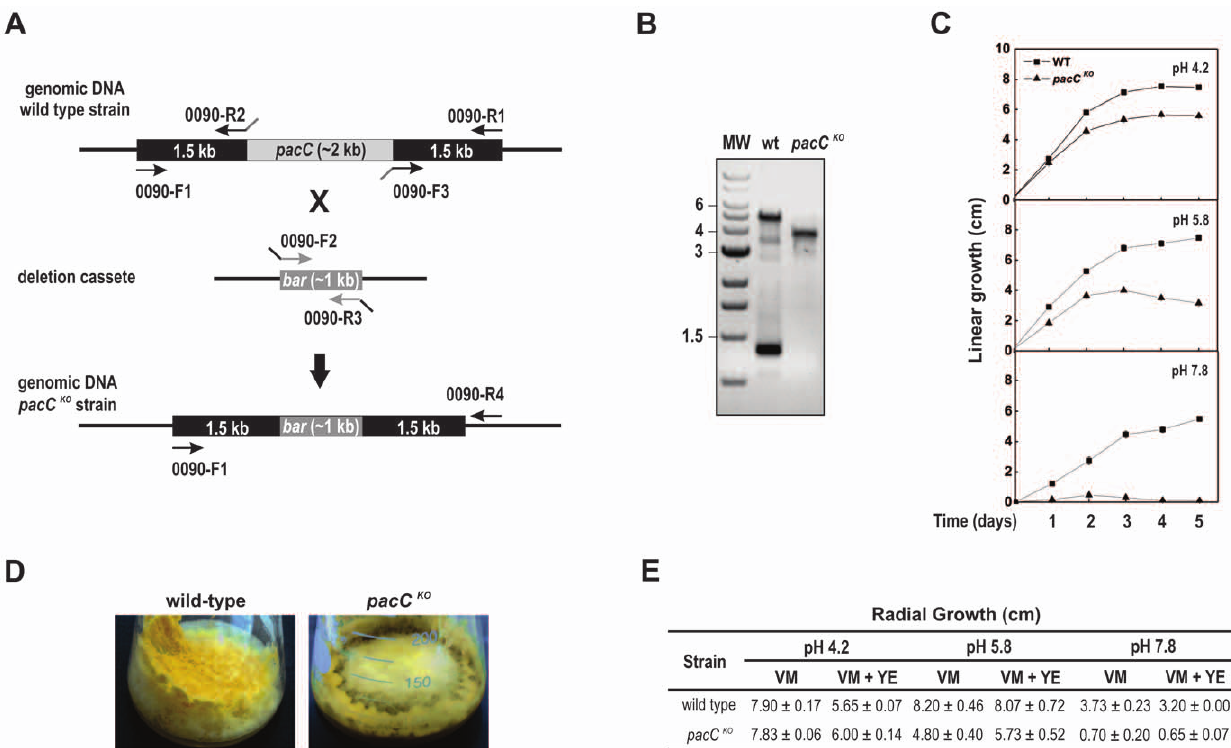
Figure 1. pacC gene knockout and phenotypic analysis of the mutant strain. (A) Schematic illustration of the pacC gene knockout strategy. (B) Diagnostic PCR for validation of the pacC knockout was performed by using 0090-F1 and 0090-R4 oligonucleotides (Table 1). (C) Linear growth analysis. Apical extension of basal hyphae was determined in race tubes, as described in Material and Methods. The results shown are the average of three independent experiments. (D) Melanization. Strains were cultured in 250 mL flasks containing VM medium for 10 days (3 days at 30 u C in the dark and 7 days at room temperature in ambient light/dark). Melanization can be visualized as brown pigment formation in the pacC KO strain. (E) Radial growth analysis. Basal hyphae growth was examined after cultivating the strains on plates containing solid VM medium, as described in Material and Methods. Growth was expressed as colony diameter.